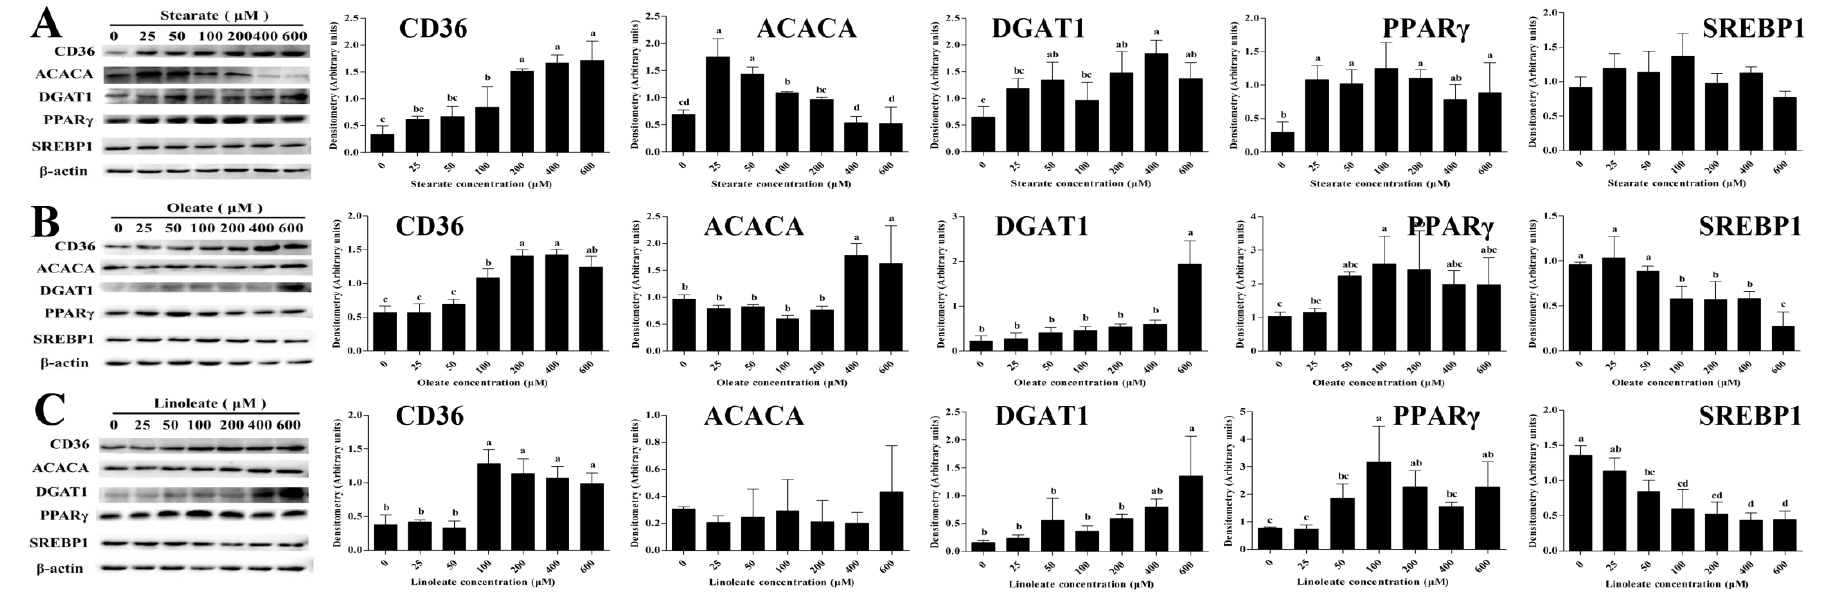
Figure 5. Effect of stearate, oleate and linoleate on the expression of proteins involved in lipid synthesis in pMECs. pMEC cells were incubated with 0 (control), 25, 50, 100, 200, 400 and 600 μM stearate ( A ), oleate ( B ) and linoleate ( C ), respectively, for 24 h. The proteins were separated by electrophoresis on a 5~12% polyacrylamide gel and transferred to nitrocellulose membranes, then the chemiluminescent signal was detected by using ECL reagents and bands were quantified by image processing software (Image Pro Plus 6.0). The expression levels of CD36, ACACA, DGAT1, PPARγ, and SREBP1 were normalized by that of β-actin. The data are expressed as the mean ± SD ( n = 3). Comparisons between groups were performed via ANOVA and Tukey’s range test for multiple comparisons. Different letters indicate statistical significance between different concentrations of stearate, oleate and linoleate treatment groups ( p < 0.05).